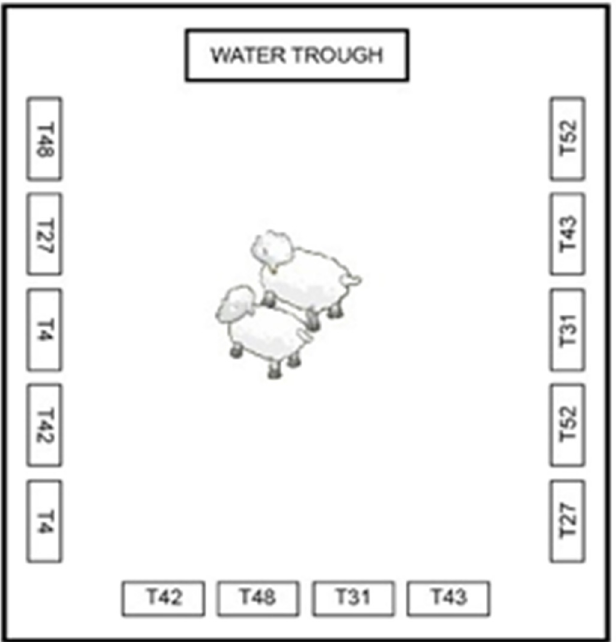
Figure 2. Schematic of one of the six 3 m × 3 m outdoor feeding pens illustrating the layout of the 14 feeders with indicative positions of the seven tedera accessions.